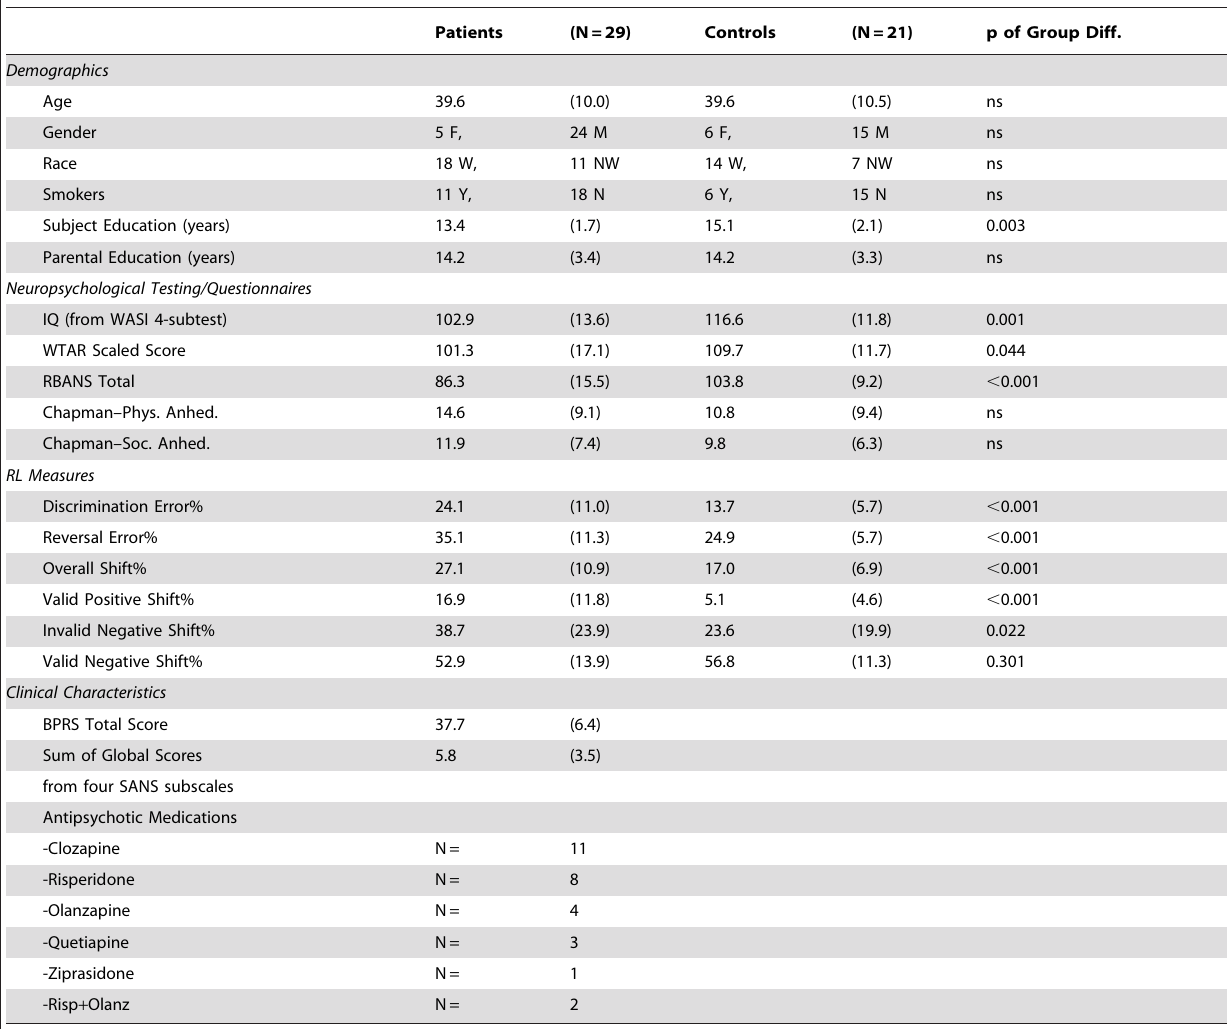
Table 1. Subject characterizing information.